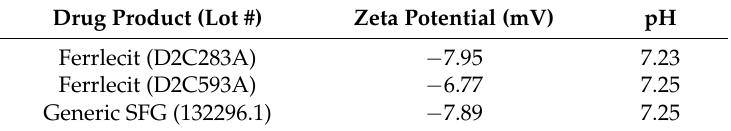
Table 5. Zeta potential and pH levels of Ferrlecit (D2C283A and D2C593A) and generic SFG (132296.1).